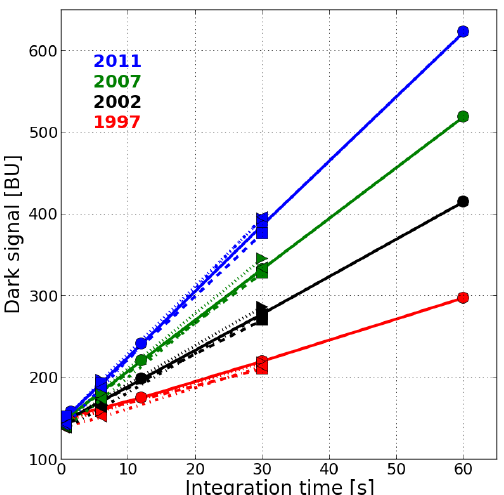
Figure 12. Dark signal in binary units (BU) as a function of inte- gration time for January 1997 (red), 2002 (black), 2007 (green), and 2011 (blue), respectively. Different symbols and line styles denote channels 1a (solid), 2b (dotted), 3 (dashed), and 4 (dash-dotted).